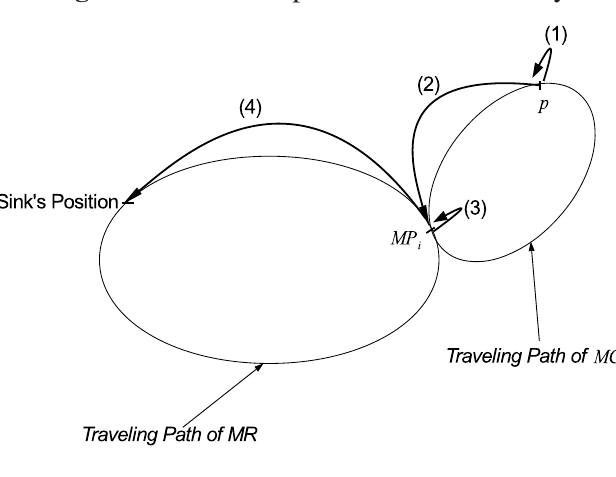
Figure 4. Time components of data